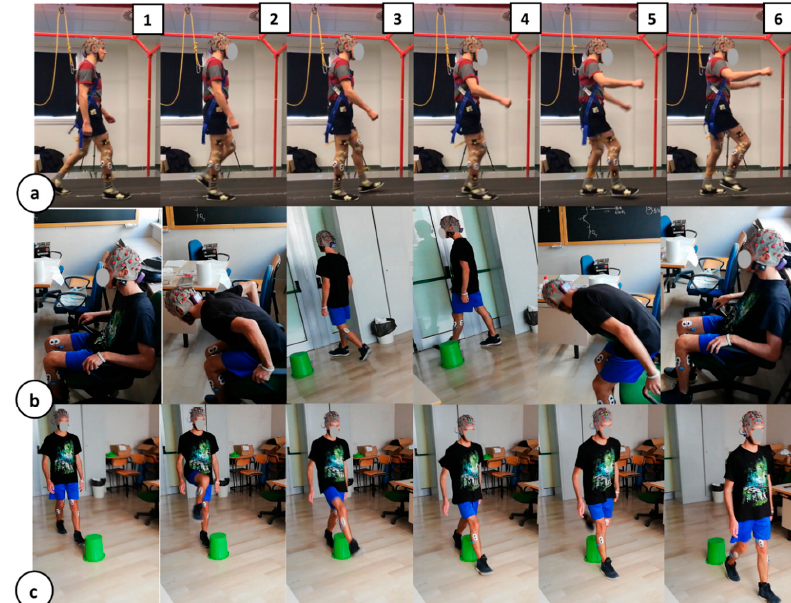
Figure 2. Experimental protocols grid. Each row in the panel represents a 6-frame demo sequence of the experimental protocol carried out by the participants. ( a ) Steady walking to near fall (slip) protocol; ( b ) Chair transfer via timed up and go test; ( c ) Balance-challenging obstacle